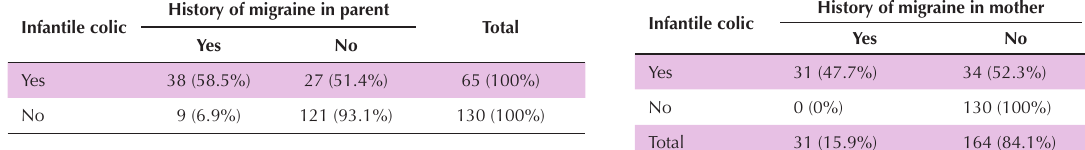
Table 4. Frequency distribution of infantile colic based on migraine history in the mother Infantile colic